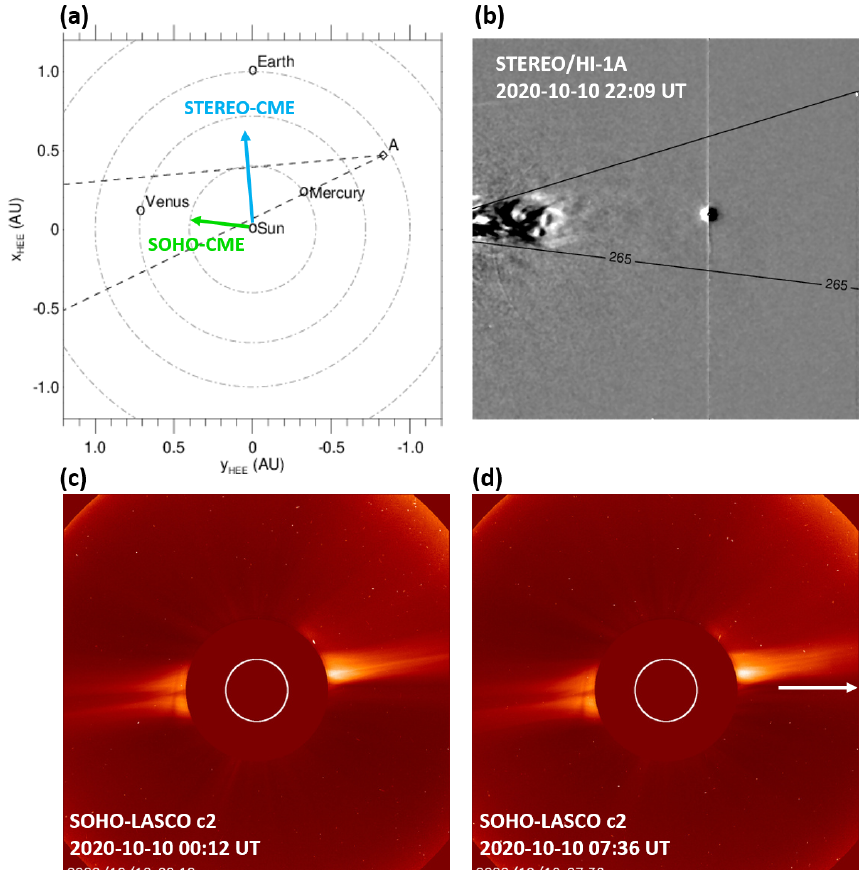
Figure 11. STEREO and SOHO observations. (a) Planet and STEREO A (A) positions and elongation range of the field of view in the plane of the sky of STEREO-A/HI1 (this is a 20 ◦ angle in the two dimensions). The blue and green arrows indicate the direction of the nose of the CMEs seen by SOHO and STEREO nearly simultaneously. (b) STEREO-A/HI1 image in a running difference format (where, in each case, the previous image is subtracted from the current image to highlight changes). The most northern and southern position angles of the CME spans are plotted as black lines, and Venus is the bright dot towards the centre. (c, d) SOHO–LASCO c2 images before and during the CME transit, respectively. The white arrow indicates the plasma motion off the western limb, which is more evident at the movie created at the SOHO Movie Theater (https://soho.nascom.nasa.gov/data/Theater/, last access: 15 September